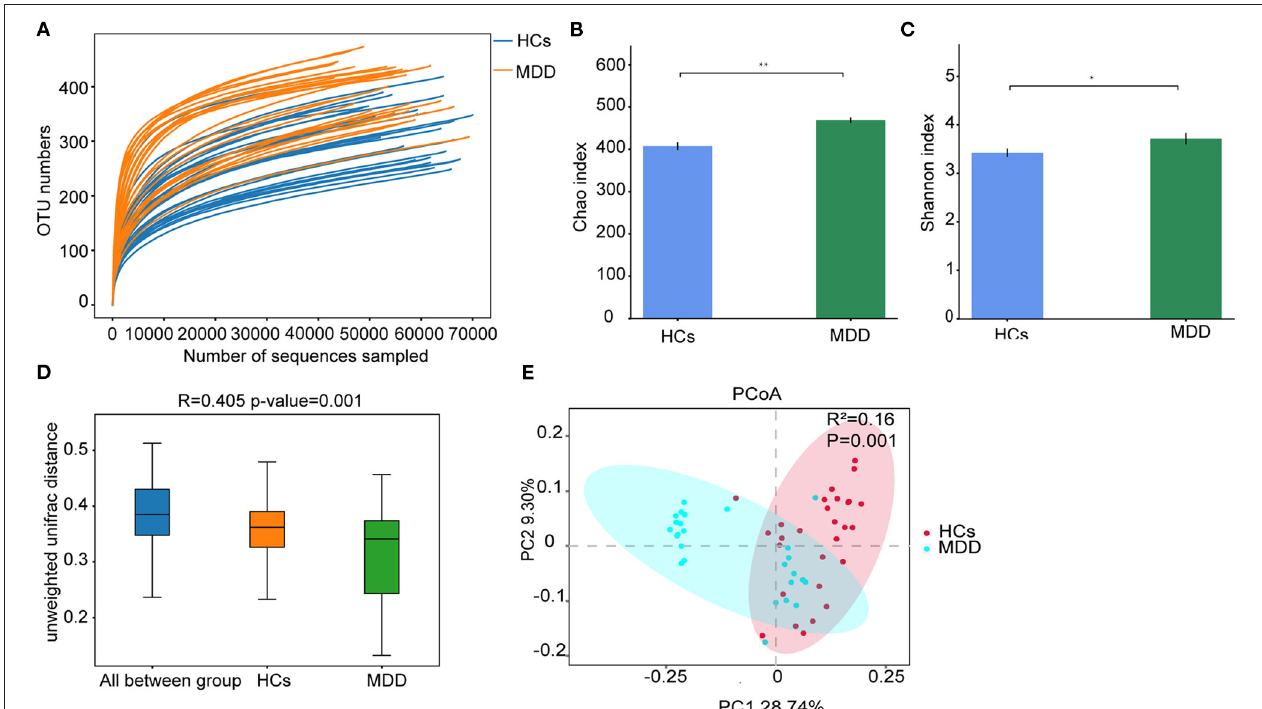
FIGURE 2 | MDD leads to significant structural and functional changes in the gut microbiota. (A) Rarefaction curve from MDD and HCs. (B) α -Diversity on the Chao index between groups. (C) α -Diversity on the Shannon index between groups. (D) β -Diversity on unweighted UniFrac between groups. (E) PCoA of the gut microbiota metagenomes between groups. * p < 0.05, ** p <